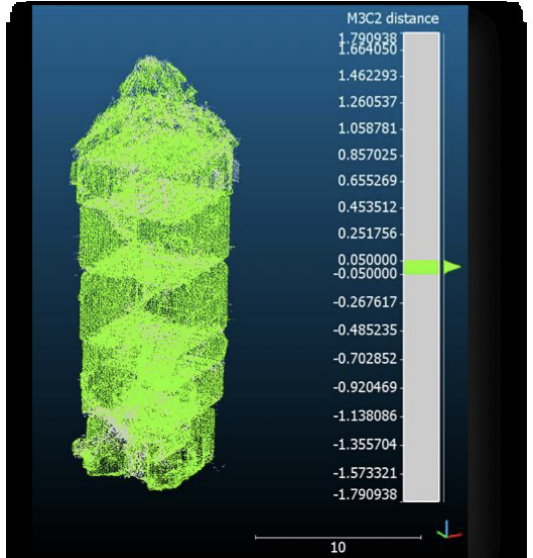
Figure 3: FARO-GeoSLAM comparison